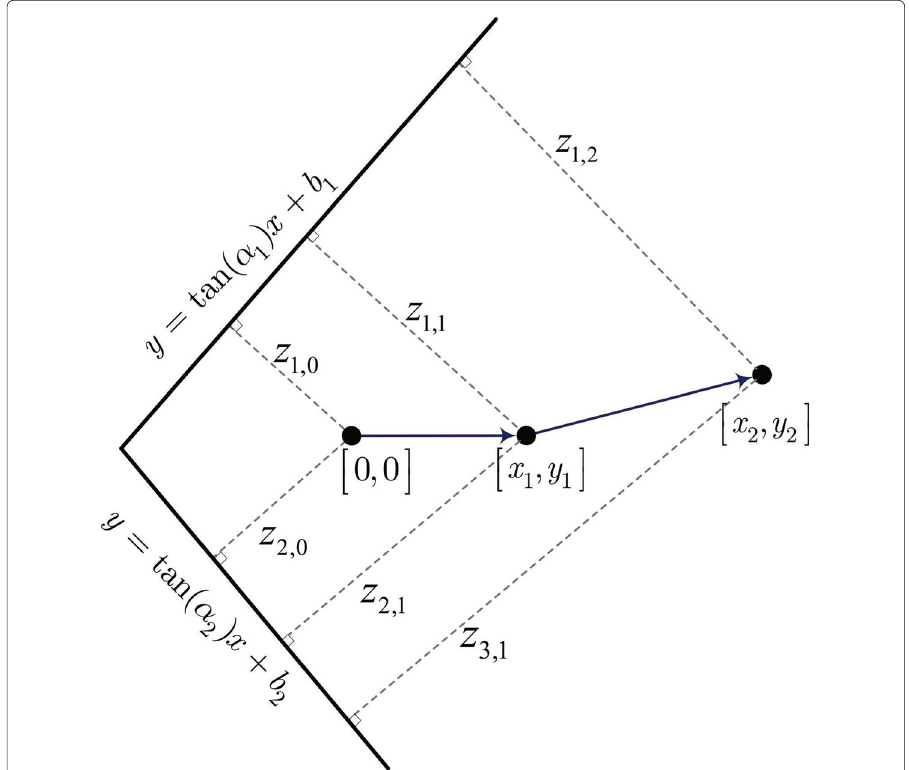
Fig. 2 Measurement model drawn for simplicity for two walls. Each wall is defined by the following equation y = tan (α l ) + b l for l = 1,2. The angle α l and offset b l determinants the wall l ’s equation in the